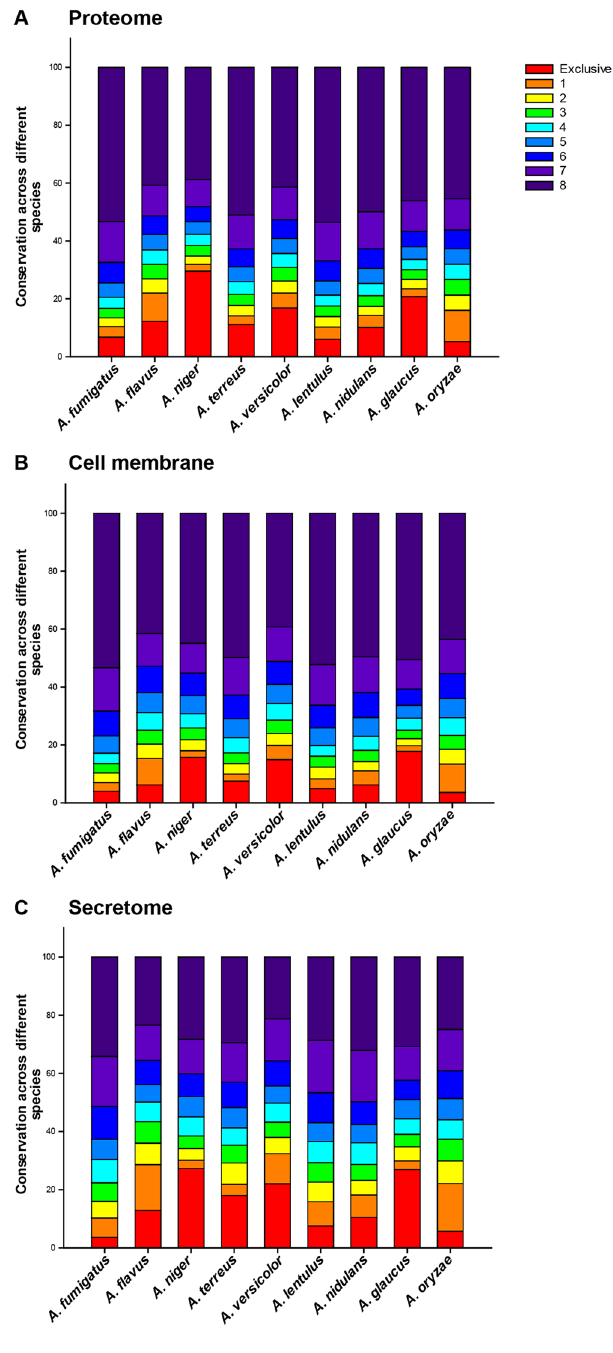
Figure 4. Conservation of ( A ) complete proteome, ( B ) the set of cell membrane proteins, and ( C ) the set of secreted extracellular proteins across the nine Aspergillus species considered here. The fraction of proteins that are unique to a specific Aspergillus species is shaded in orange at the bottom of the stacked bar chart while the fraction of proteins conserved across all nine Aspergillus species are shaded in dark violet at the top of the stacked bar